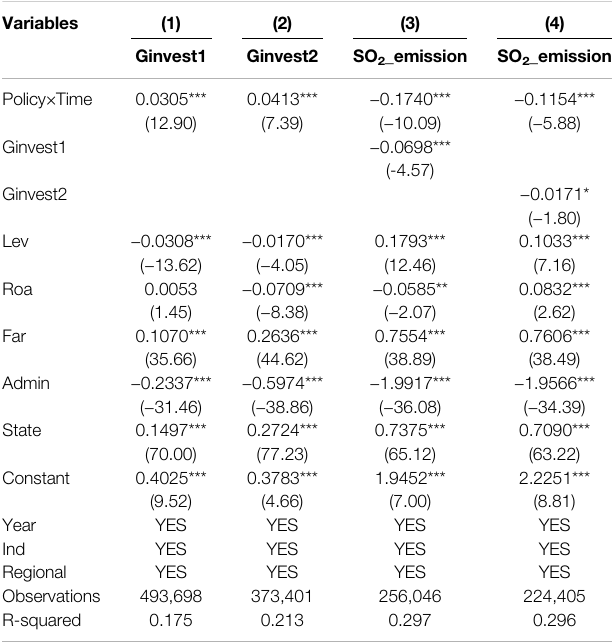
TABLE 7 | Mediation effect estimation results: environmental investment as mediator.